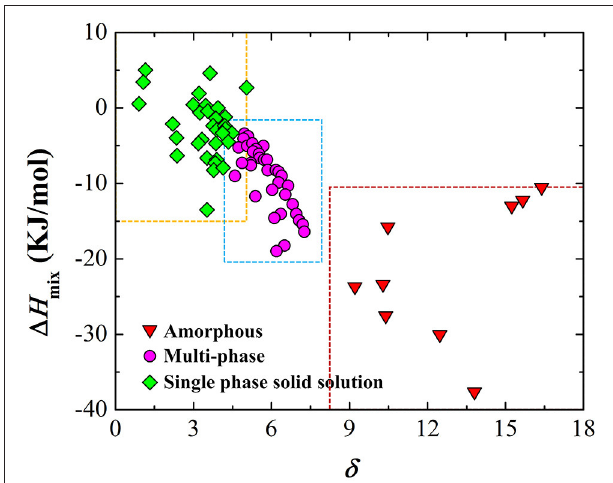
FIGURE 2 | The atom size difference parameter δ vs. the mixing enthalpy 1 H mix for a variety of as-cast HEAs with different